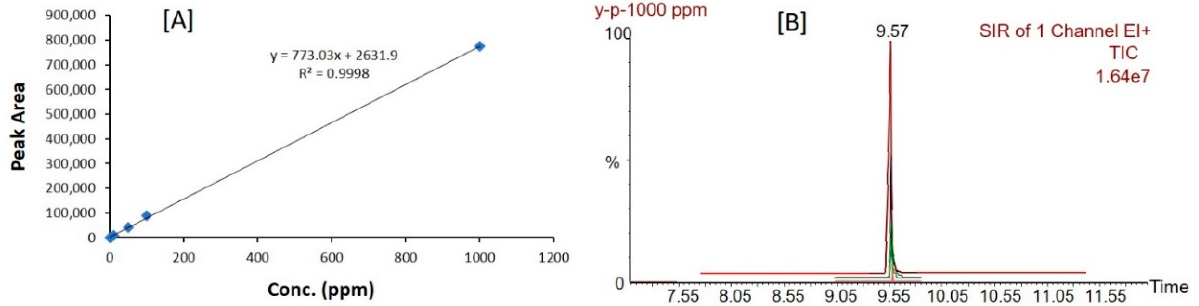
Figure 5. Calibration curve ( A ) and peaks ( B ) of propofol constructed by GC/MS sample analysis. The chromatographic results from the GC/MS technique suggested that, the separation of the propofol peak and its detection was ideal without any interference of the excipients used in SNEDDS dosage form. The propofol analyte was well separated at the retention time of ~9.57 min without having any interference of degradation product (Figure